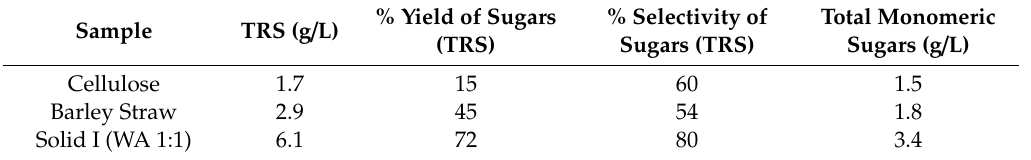
Table 4. Total reducing sugars (TRS) measurements obtained from the samples after the hydrolysis reaction.